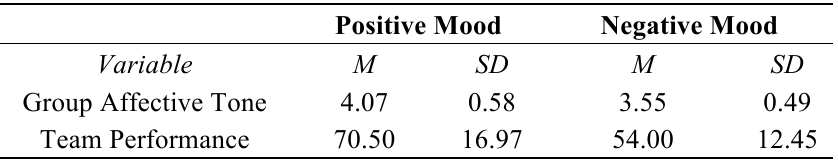
Table 2. Effects of leader’s mood